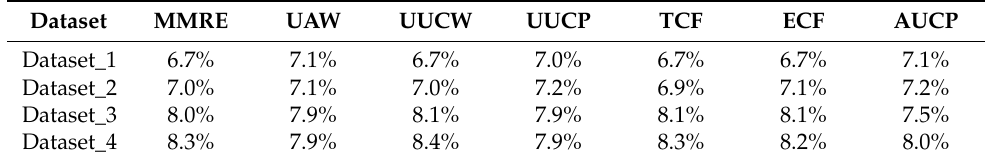
Table 10. Influence of the input values on the change in MMRE (UCP).